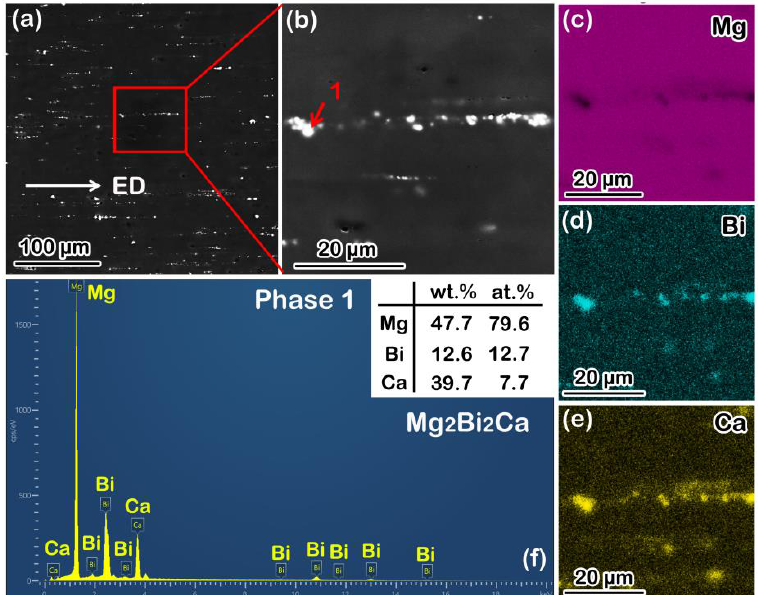
Figure 14. SEM analysis of the as-extruded BX31 alloy from longitudinal section: ( a ) SEM image; ( b ) high magnified view from red frame in ( a ); ( c – e ) SEM-EDS mapping scanning results containing Mg, Bi and Ca elements from ( b ); ( f ) SEM-EDS point scanning result from phase 1 marked by red arrow in ( b ).